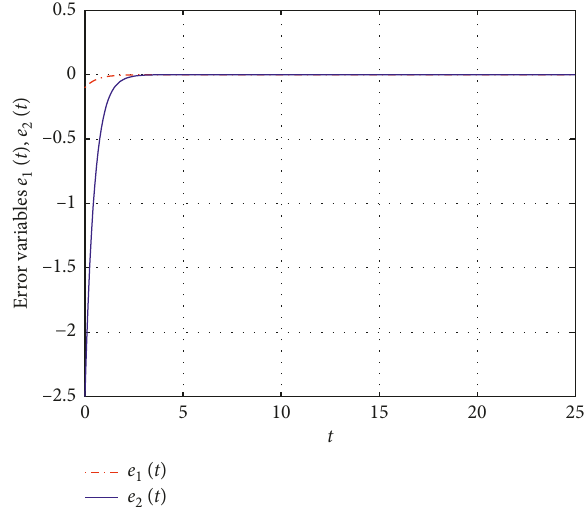
Figure 8: The simulation result for error system with � 1 . 72 ,k � 0 , and k � 1 . 72. k 1 2 3